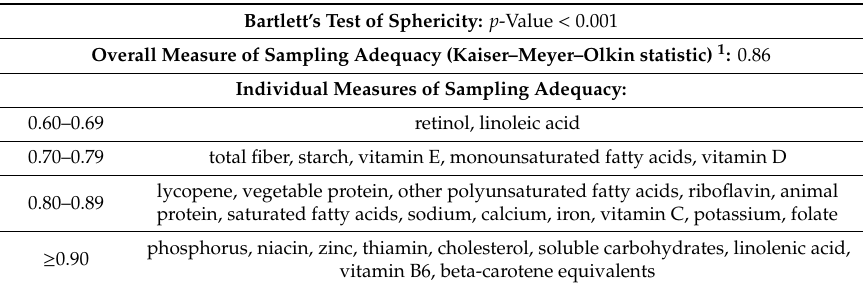
Table 1. Factorability of the correlation matrix of the original nutrients: Bartlett’s test of sphericity and measures of sampling